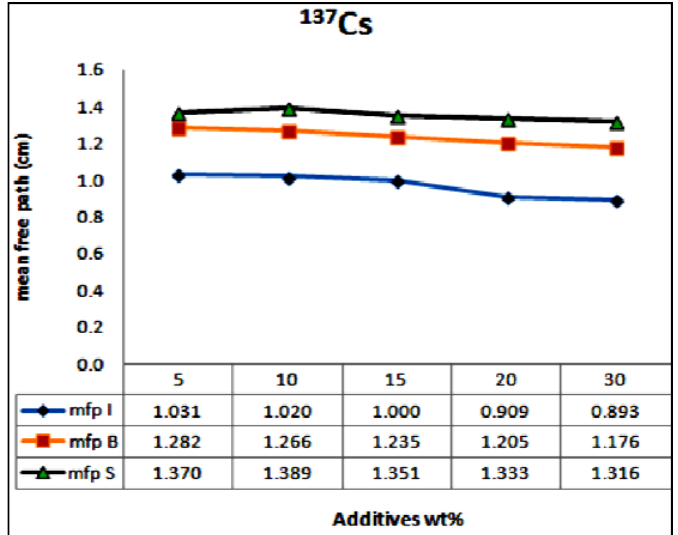
Figure 8. Variation of mfp as a function of the additives wt % for the 137 Cs source, µI, µB and µS standing for the attenuation coefficients for the tested samples of iron particulates, steel balls and steel slags, respectively